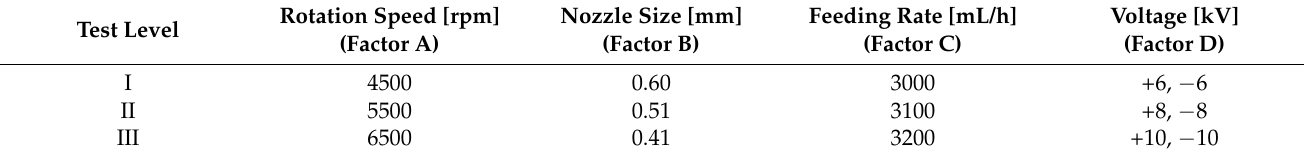
Table 2. Orthogonal test factor levels which are applied in Tables 3 and